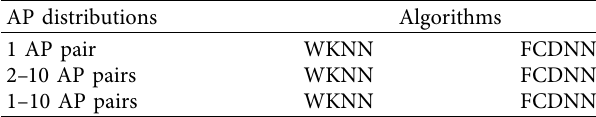
Table 2: Simulation scenario.